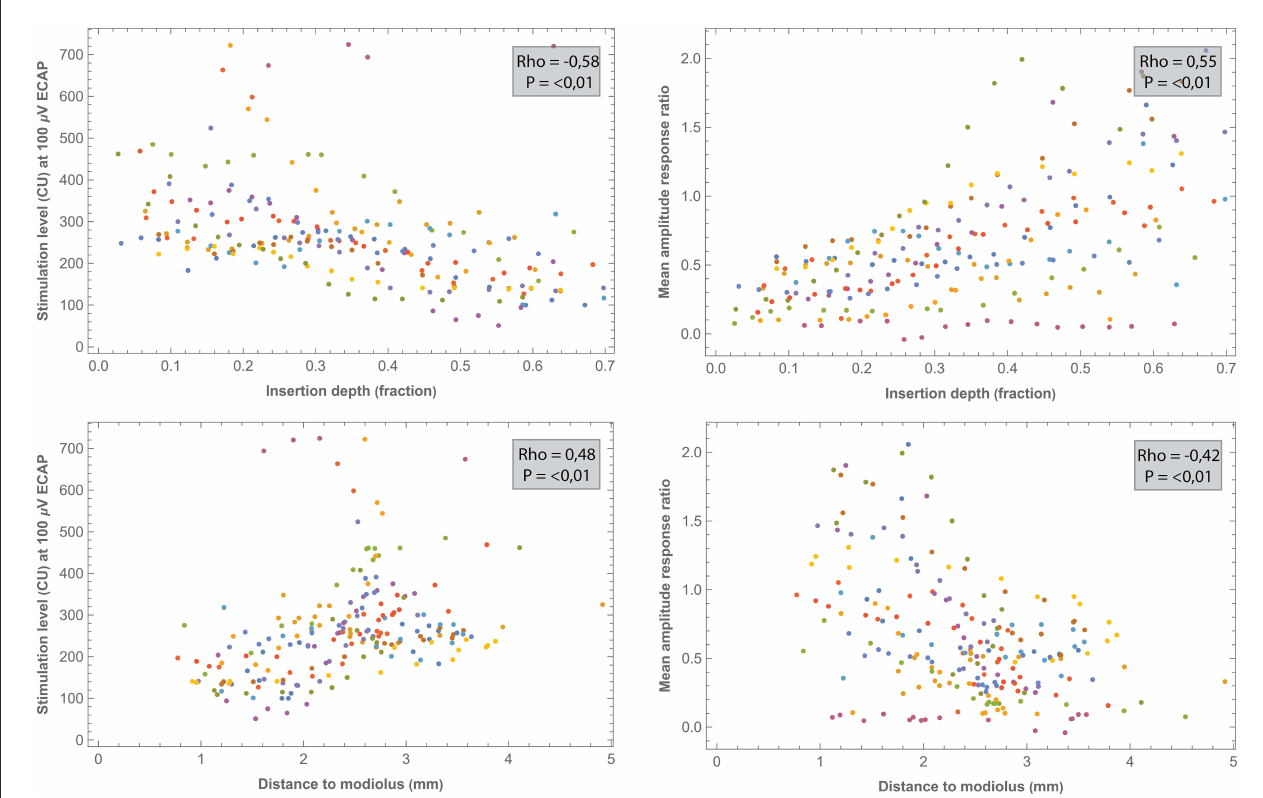
FIGURE8 Comparisons between intraoperative ECAP parameters (100 µ v ECAP and mean amplitude response ratio) and electrode positioning. All correlations were significant after the Bonferroni correction ( p < 0.001). Each subject (contributing 16 electrodes if no missing values) is represented by a different color. Outliers of one NRI measurement (EP12) were out of the window and are not shown.